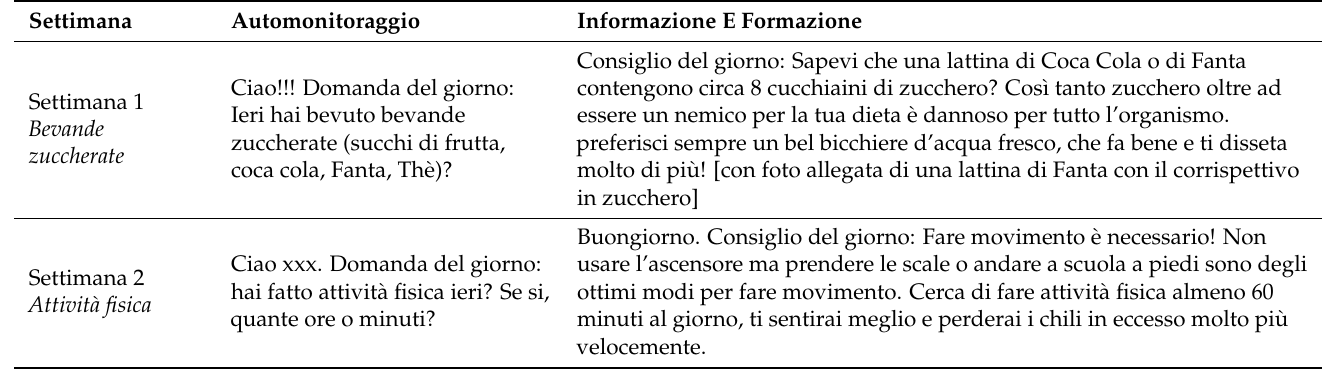
Table A2. Scheme of “self-monitoring messaging” (Italian